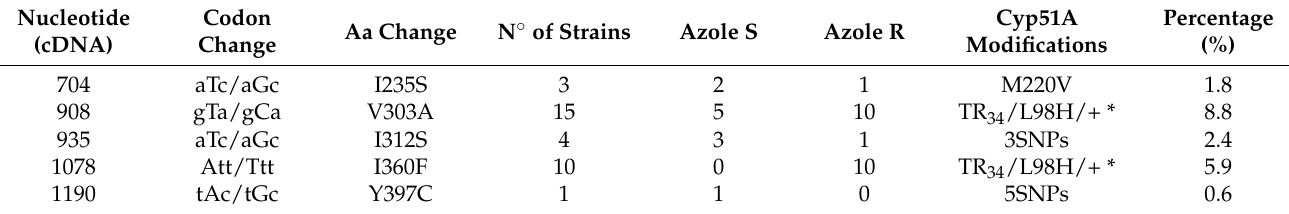
Table 4. Analysis of the SSD Hmg2 amino acid substitutions found in our set of 170 A. fumigatus clinical strains. Concomitant Cyp51A azole resistance mechanisms are also